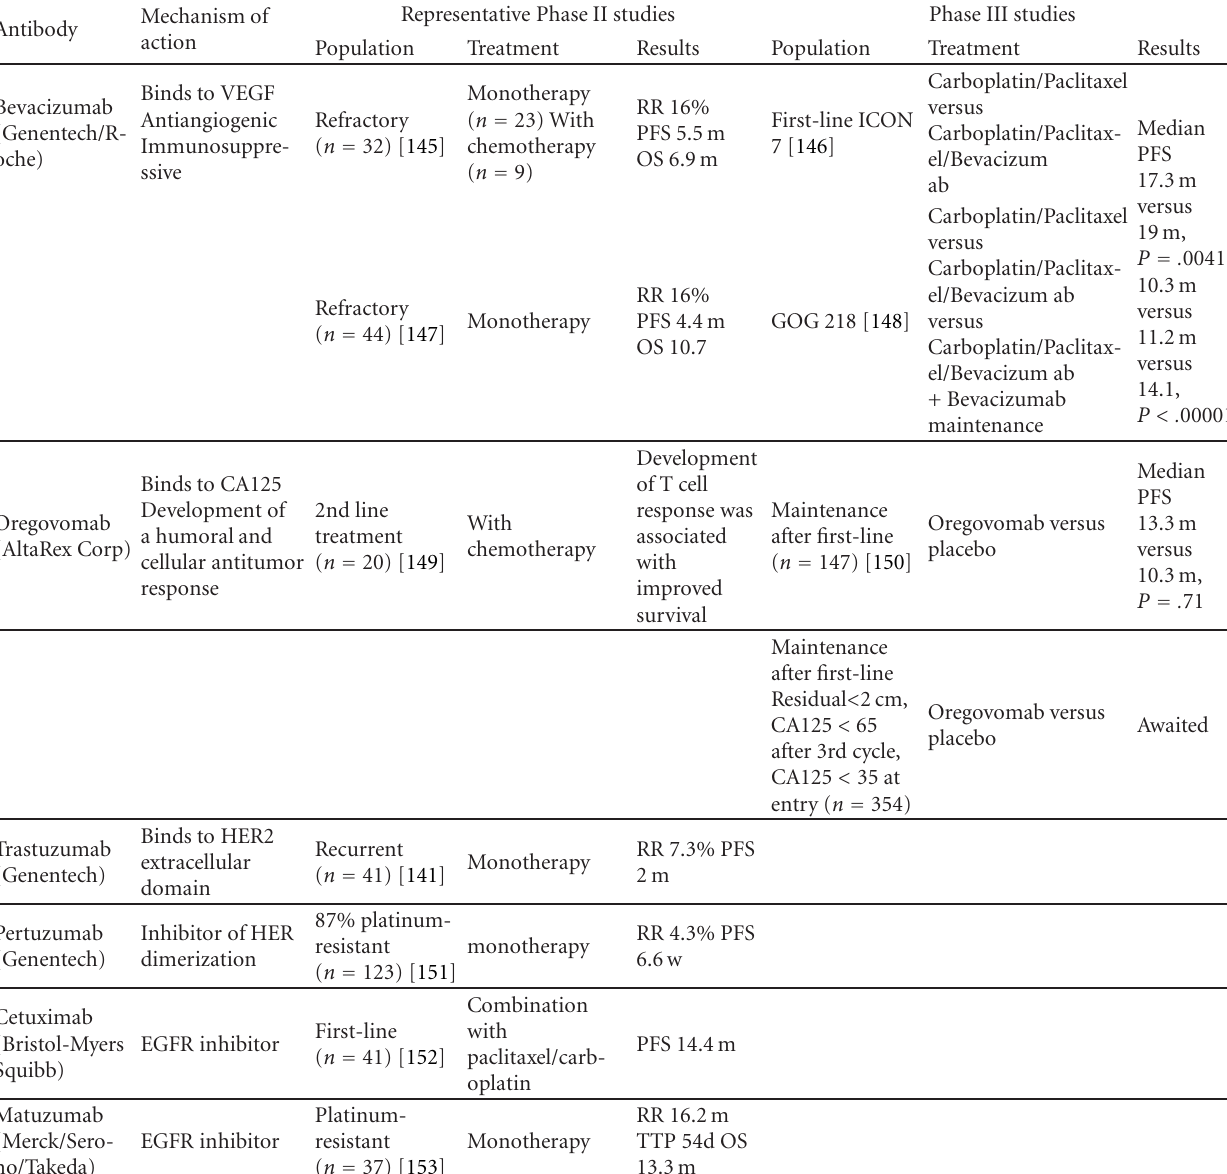
Table 1: Selected clinical studies of monoclonal antibodies used for the treatment of ovarian